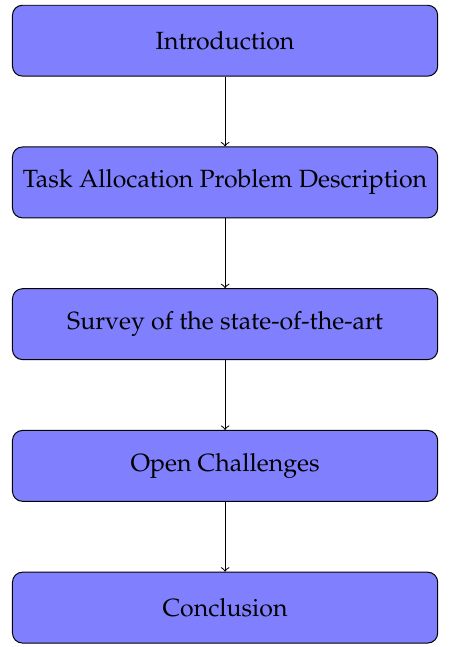
Figure 1. Illustrated layout of this